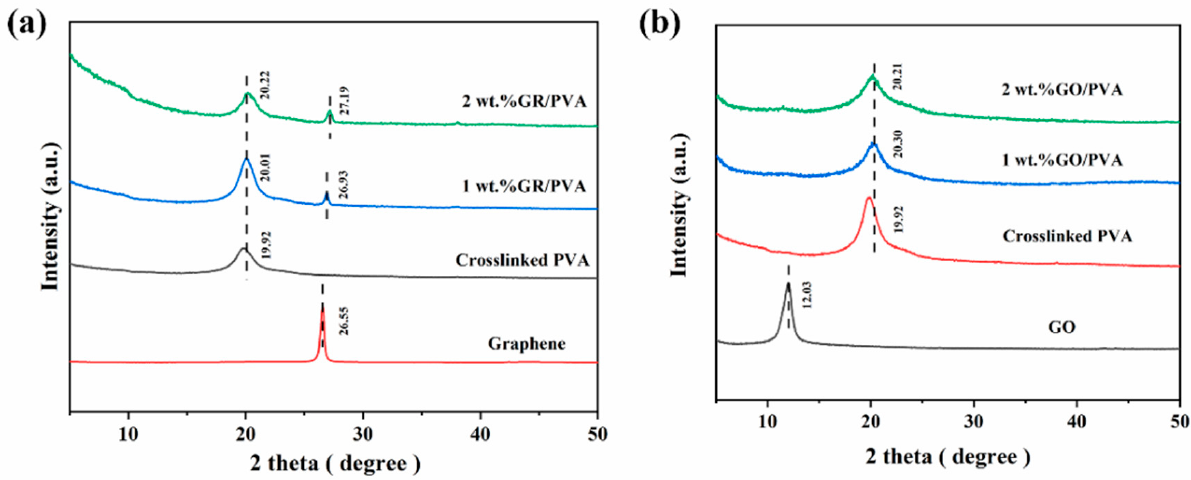
Figure 4. XRD patterns of GR, GR/PVA MMMs ( a ) and GO, GO/PVA MMMs ( b ) with different filler